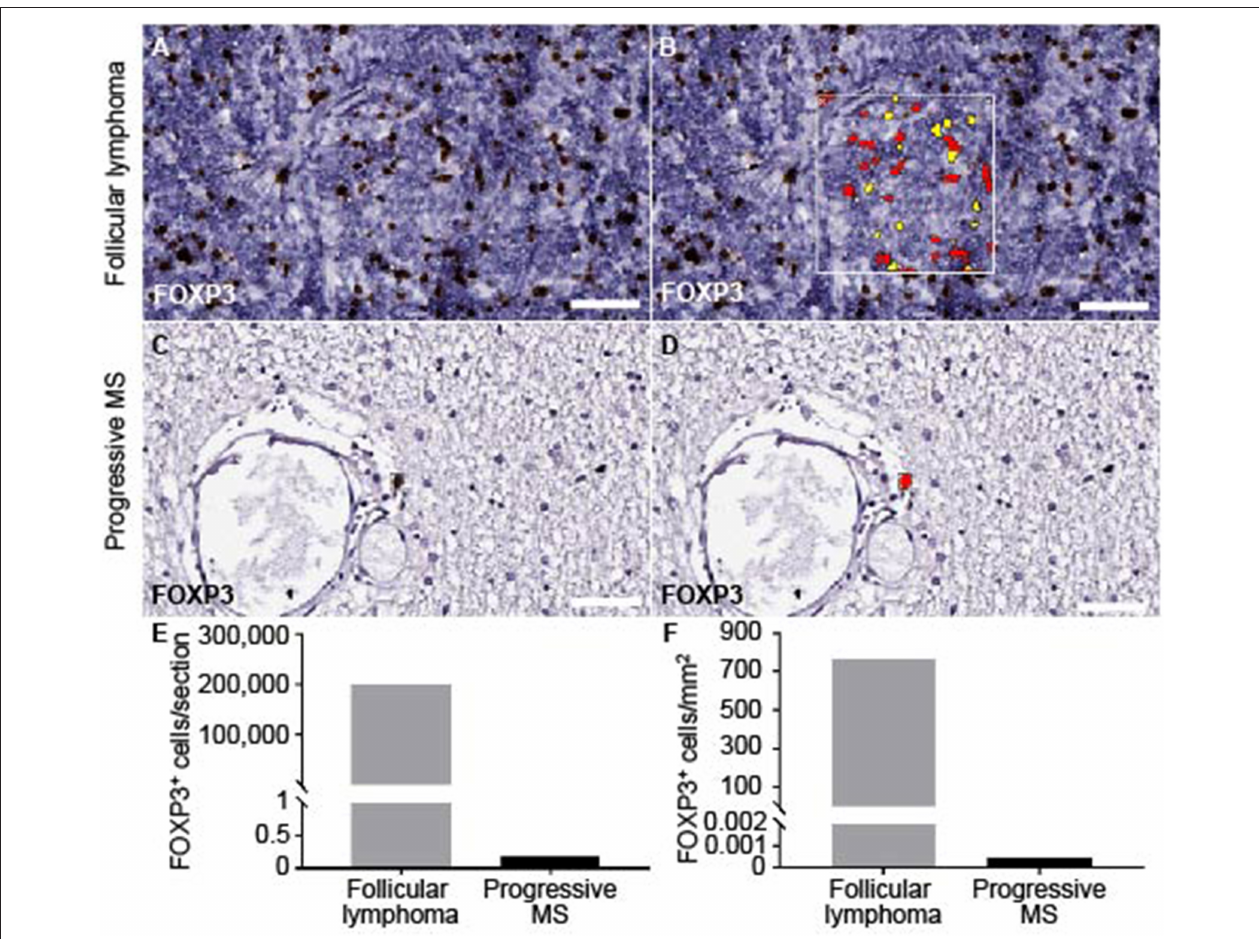
FIGURE 5 | Quantification of FOXP3 staining on brain and spinal cord of progressive MS and follicular lymphoma. The module cytonuclear v1.6 (Halo, Indica Lab) was used to define FOXP3 + in follicular lymphoma (A,B) and applied on progressive MS tissue (C,D) . Representative raw images detecting FOXP3 + staining (A,C) and the mark-up (yellow, low positive; red, highly positive) are depicted (B,D) . (E) Absolute number of FOXP3 + cells per whole section in follicular lymphoma ( M = 200849) and across progressive MS samples ( M = 0.176, n = 36) as well as (F) FOXP3 + cells per tissue area in mm 2 are counted in follicular lymphoma ( M = 767.71) and across all available progressive MS samples ( M = 0.00051, n = 36). Note, that in 83% of the samples ( n = 30) no FOXP3 + cells were detected, in 11% samples ( n = 4) one FOXP3 + cell within parenchyma, in 6% of samples 2 FOXP3 + cells within parenchyma. Scale bars indicate 50 µ